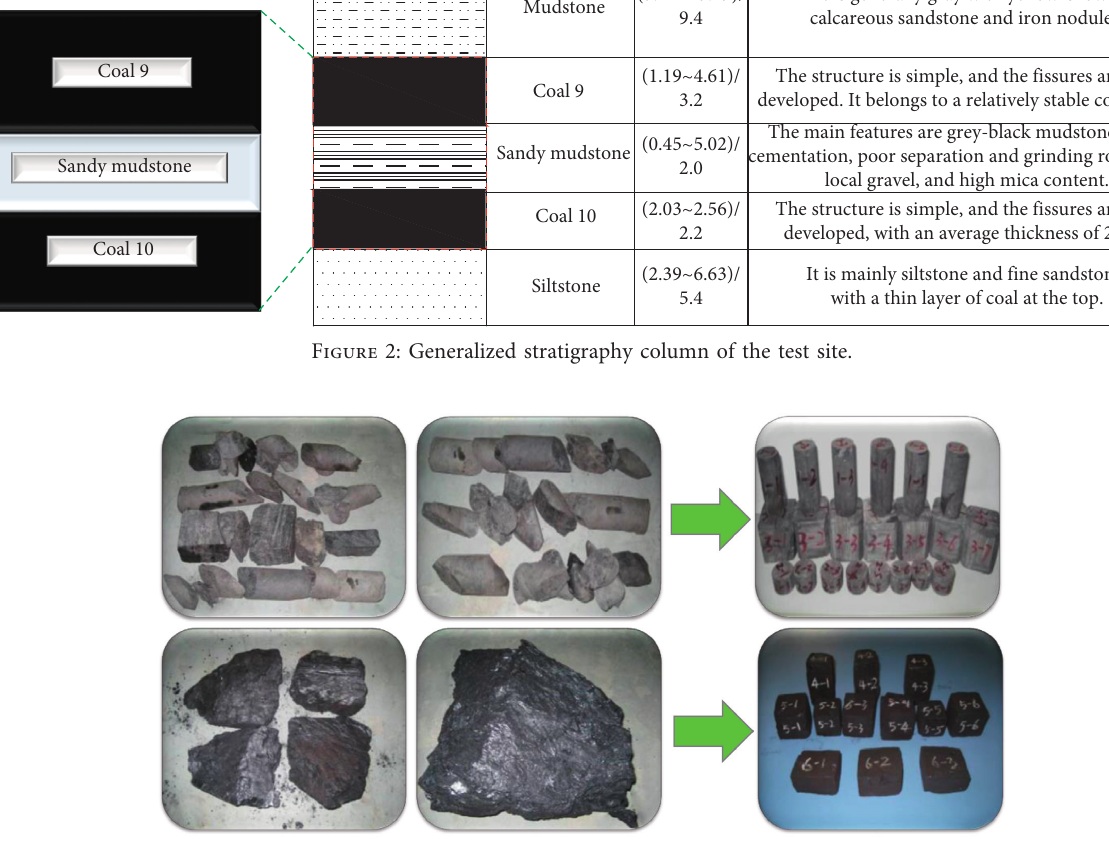
Figure 3: Coal and rock samples used in the